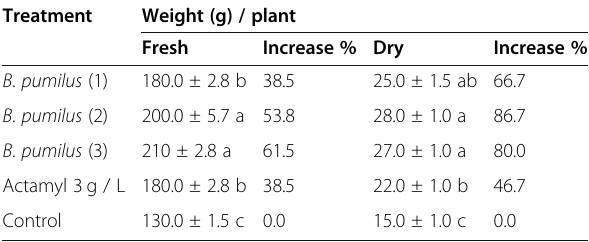
Table 3 Effect of some Bacillus pumilus isolates on some vegetative characters of strawberry plants under field conditions